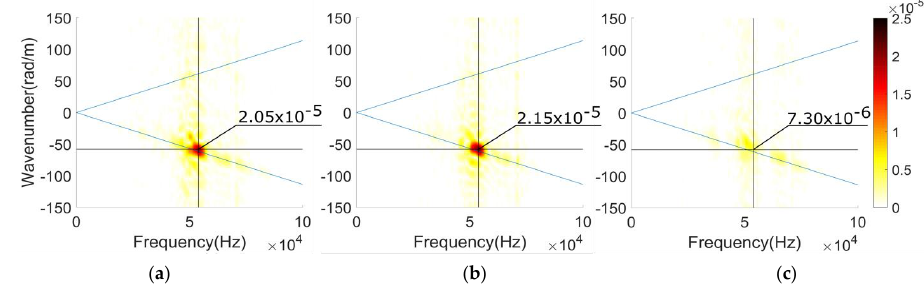
Figure 2. The 2DFFT of the transmission measurements for ( a ) the Baseline, ( b ) the Frequency- matched Resonator and ( c ) the Clamping Resonator. The diagonal lines are the dispersion curves for the forward and backward propagating S0 Lamb wave modes. The vertical and horizontal lines show where the frequency- and wavenumber-spectrum slices shown in Figure 6 are obtained. The peak values are noted in each figure.